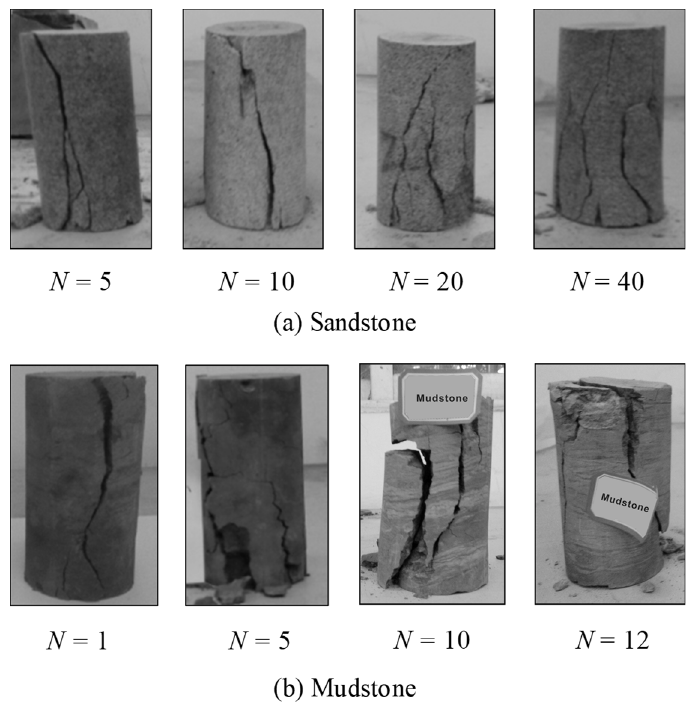
Figure 9. Failure forms of the specimens.